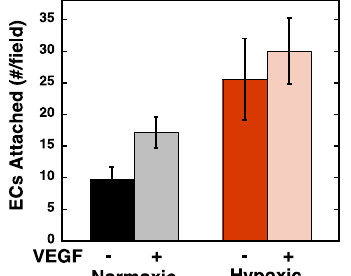
Figure 4. RPE cells were subjected to normoxia and hypoxia for 72 h. RPE cells were allowed to incubate with and without VEGF (50ng/mL), then washed, and fluorescently labeled RECs were allowed to attach for 1 h, washed, fixed, and quantified as described above (expressed as the average number of cells per field, N = 3; n =4; ±SEM). Hypoxia and VEGF significantly increased REC attachment as compared to normoxic cells ( p < 0.05). VEGF did not significantly increase REC attachment to hypoxic RPEs.